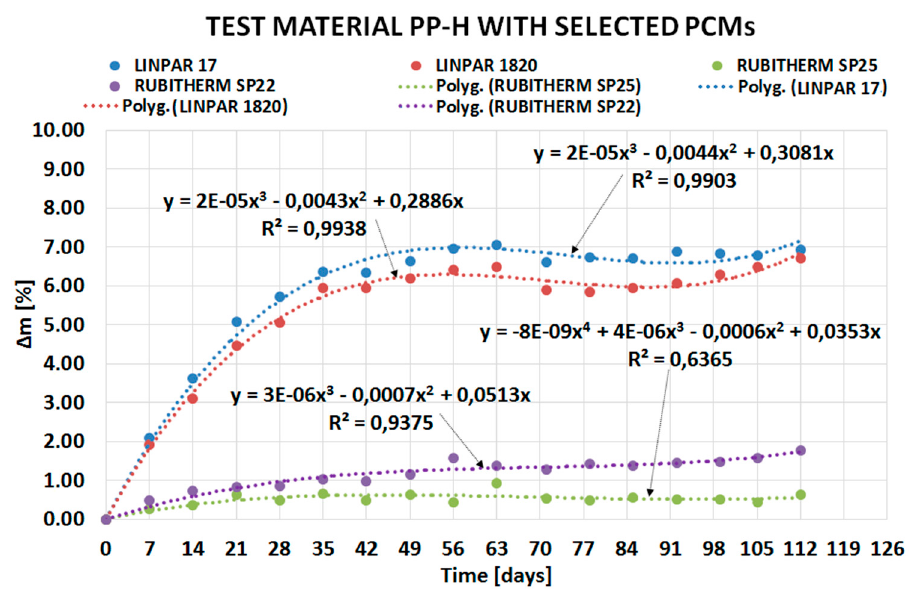
Figure 6. Comparison of the dependence of mass change of polypropylene (PP-H) caused by particular PCMs.